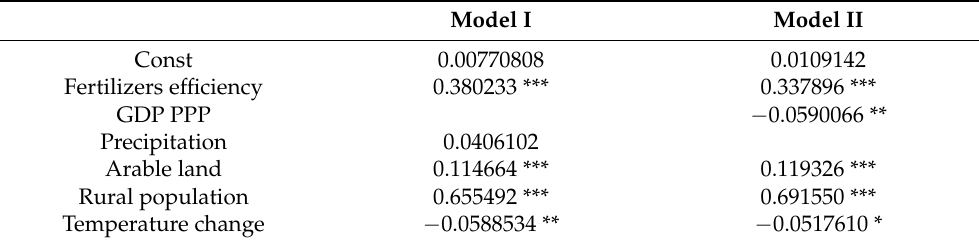
Table 4. Model estimation of SSR for the Western Balkan countries. Model I Model II Const 0.00770808 0.0109142 Fertilizers efficiency 0.380233 *** 0.337896 *** GDP PPP − 0.0590066 ** Precipitation 0.0406102 Arable land 0.114664 *** Rural population 0.655492 *** 0.691550 *** Temperature change − 0.0588534